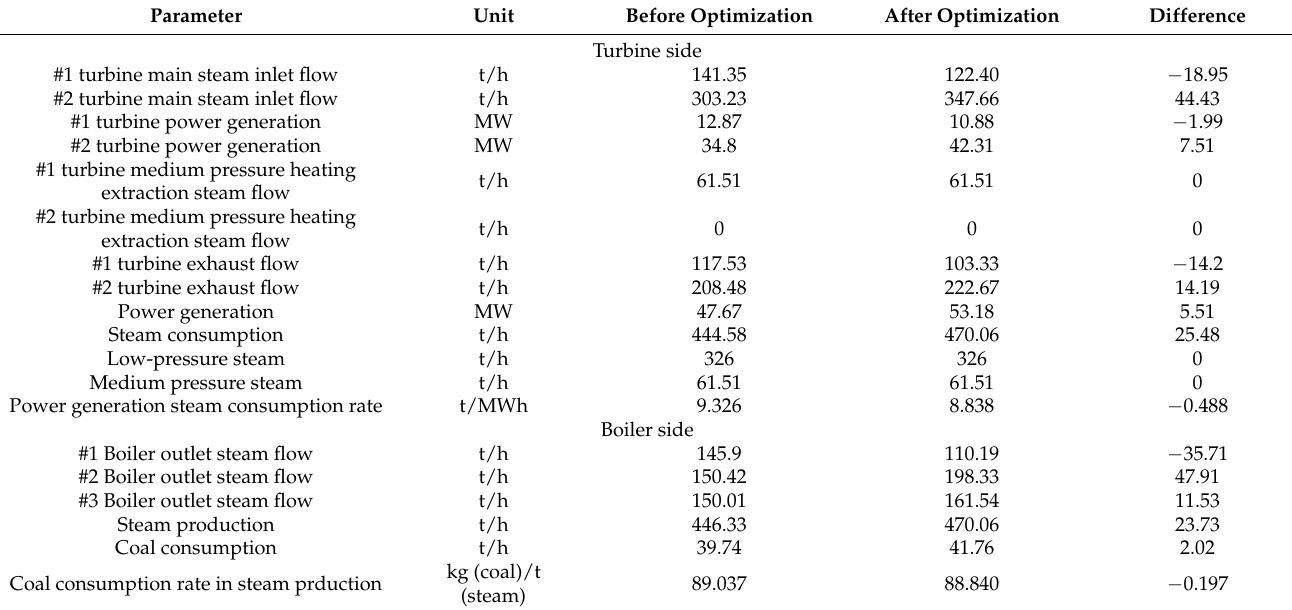
Table A2. Genetic algorithm-based load optimization distribution